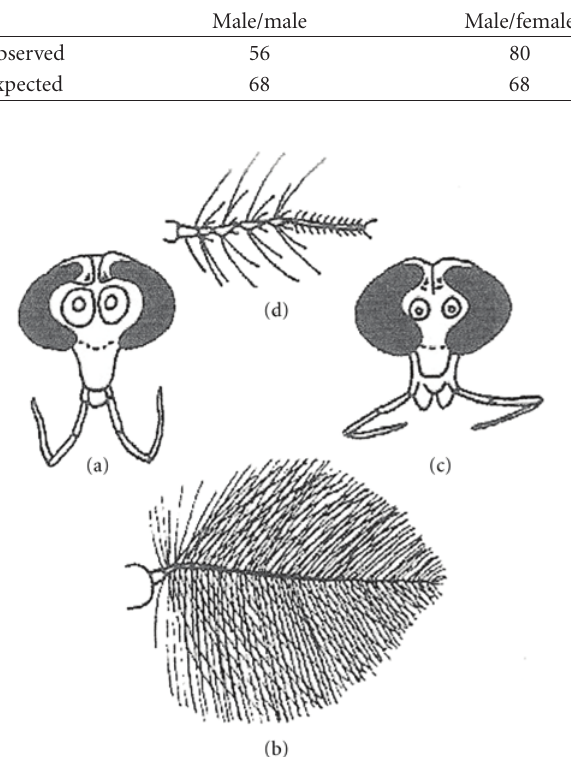
Figure 2: The sensory equipment of the chironomid midge. Front view of head of male (a) and antenna (b); (c) and (d) the same for the female. (Modified after [24], with